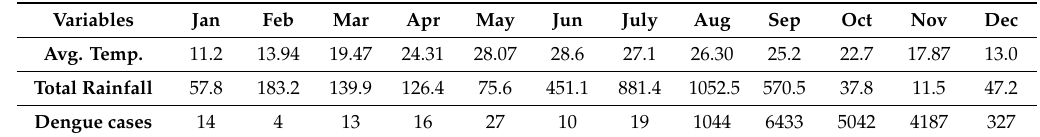
Table 2. Estimation of monthly average temperature (Avg. Temp.), total rainfall, and total dengue cases of Lahore from 2007–2012.